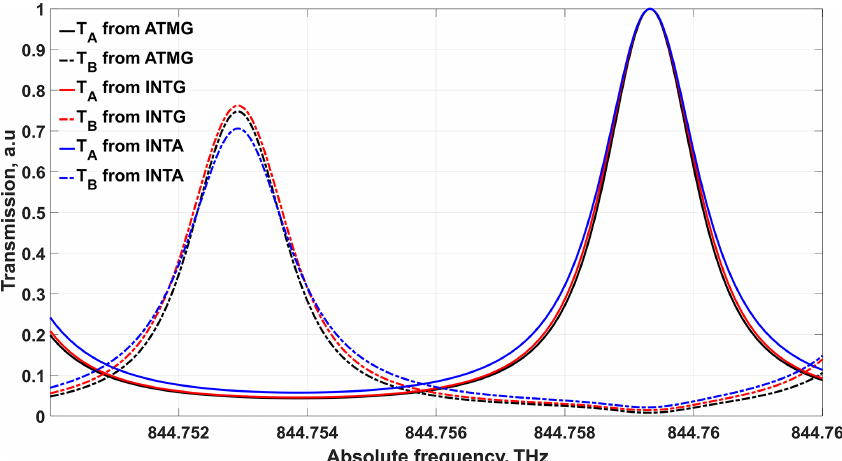
Figure 5. The transmission function of fitted FPIs from different campaigns and detection channels. The black, red, and blue groups are obtained from ATM path measurement during the BRAINS ground campaign (ATMG) in 2009, INT path measurement during NAWDEX from ground (INTG) in 2016, and INT path measurement during NAWDEX airborne measurement (INTA) in 2016,